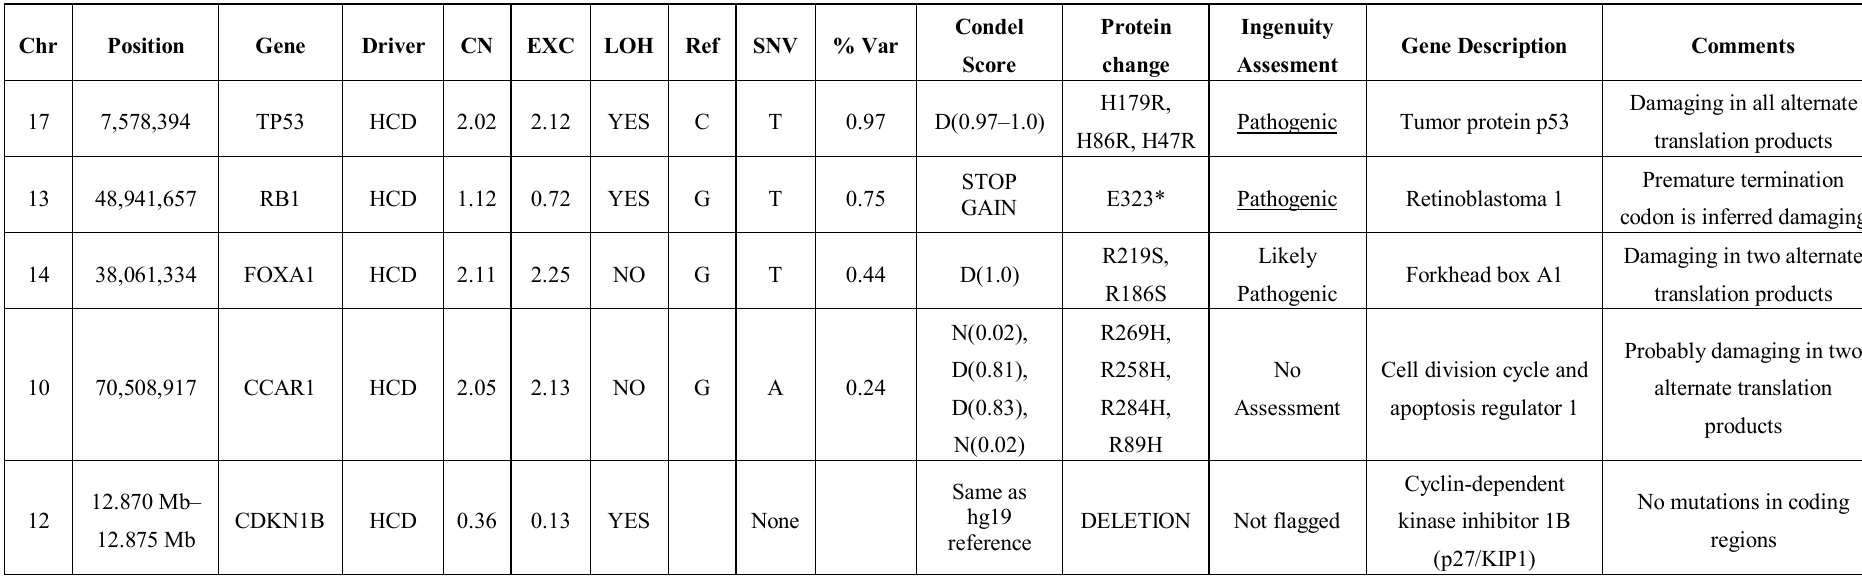
Table 1. Principal findings: Protein coding genes with somatic mutations. The copy number and location within regions of LOH are noted. The SNV in the tumor vs. normal cells is indicated in the allele column and the percent of variant reads or mosaicism is given. Condel scores (D = deleterious, N = neutral) and protein changes are shown for each predicted isoform. Premature stop mutations are indicated and assumed to be damaging. Genes confirmed by the Ingenuity analysis are indicated along with the Ingenuity